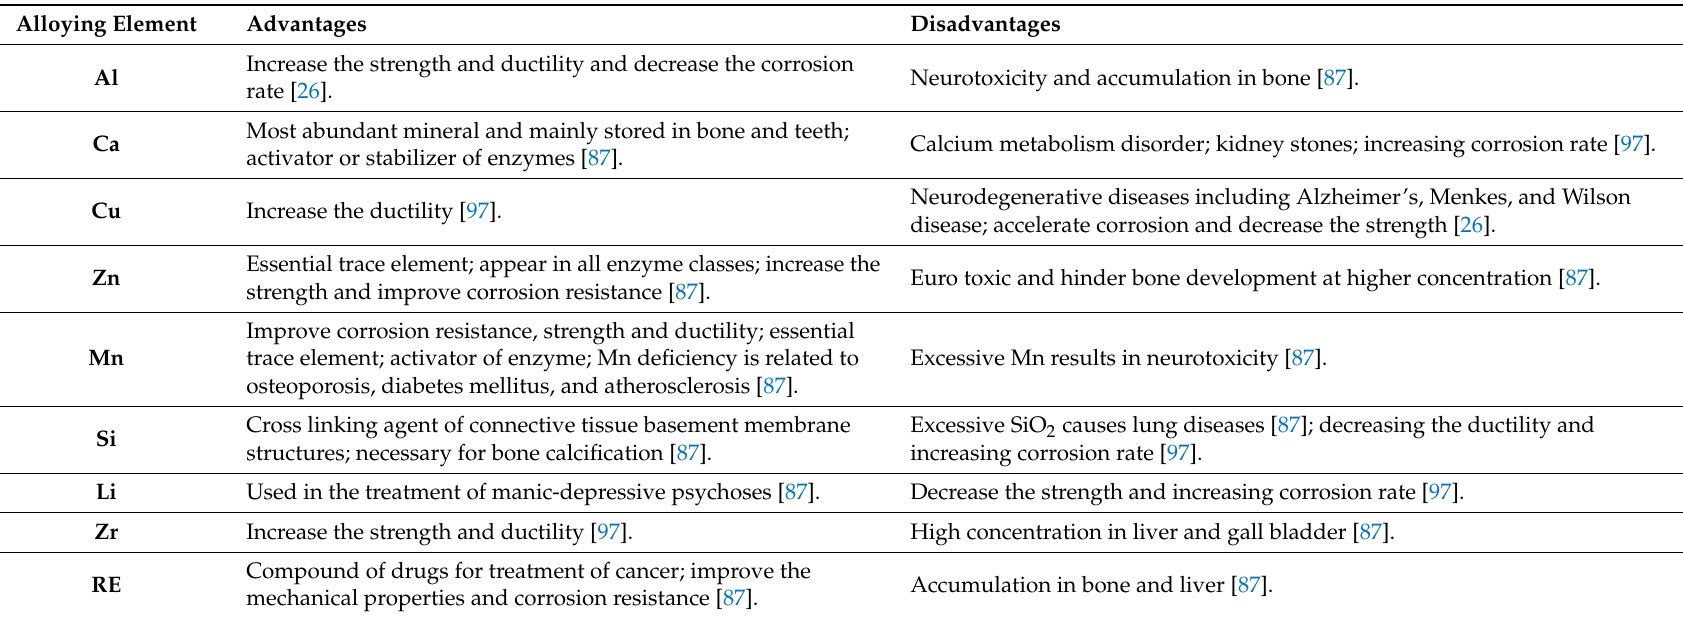
Table 4. Biological and mechanical advantages and disadvantages of alloying elements for